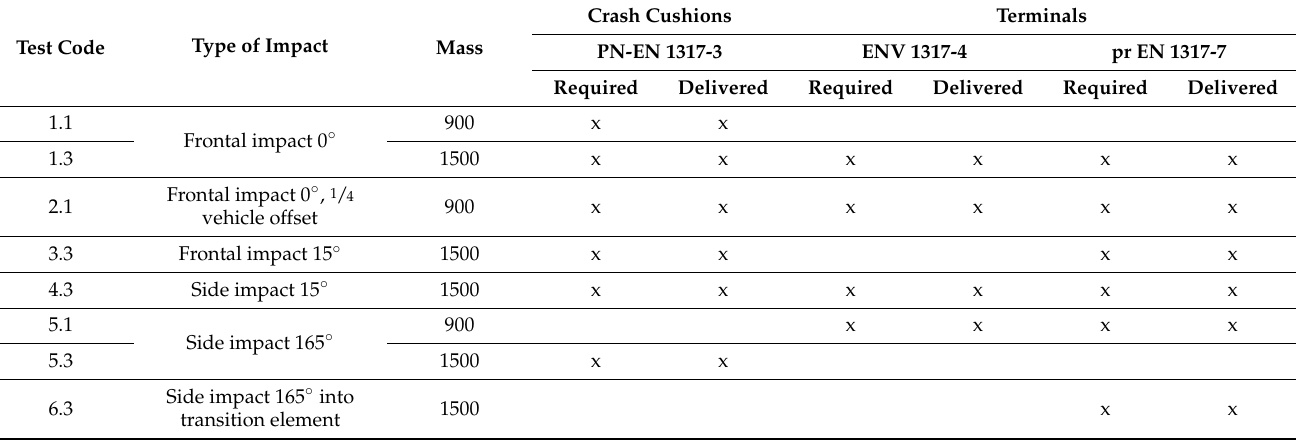
Table 2. SE Crash